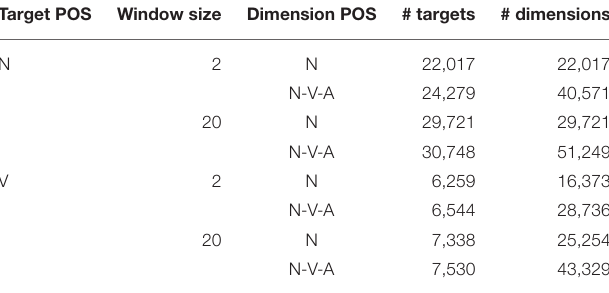
TABLE 2 | Example context words for the target noun fish within a window of ± 20 words, accompanied by co-occurrence frequencies and local mutual information (lmi)